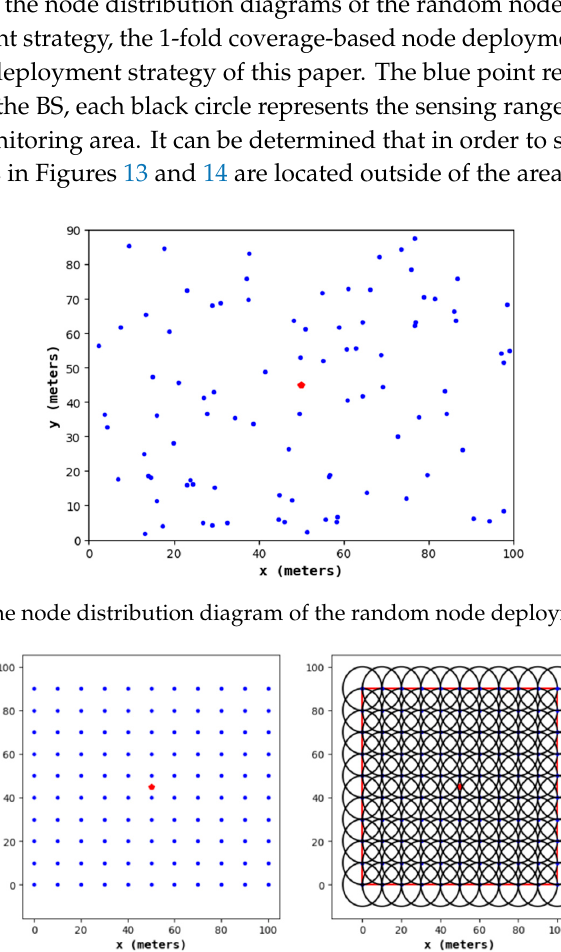
Figure 12. The node distribution diagram of the uniform node deployment strategy.